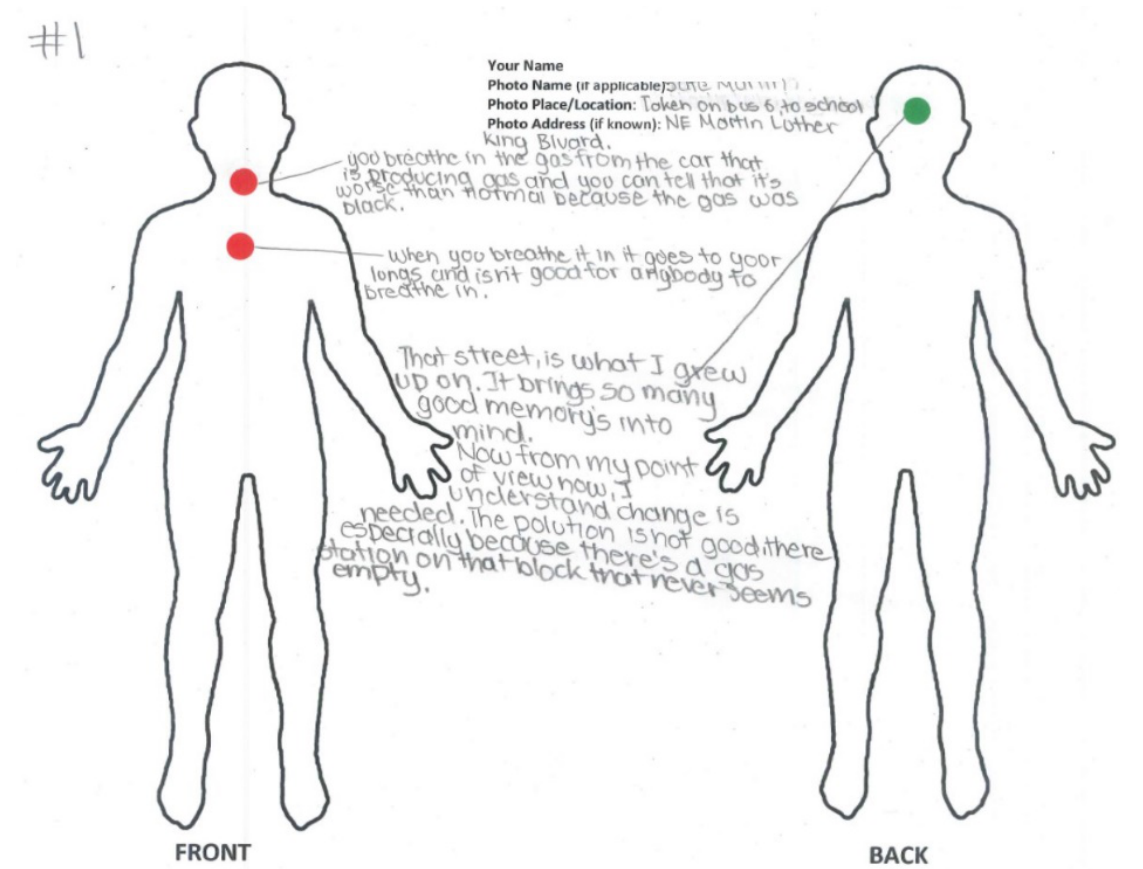
Figure 3. X-ray Mapping example produced by a youth researcher describing where and how place- based SDH affect their body.